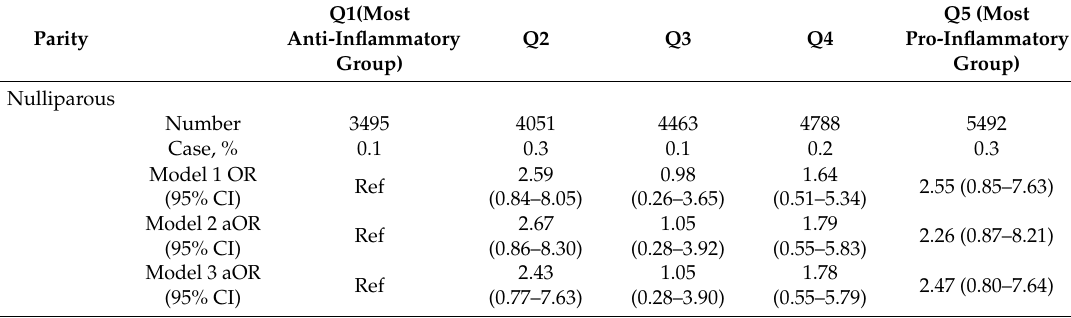
Table 5. Relationship between dietary inflammatory index and umbilical artery pH <